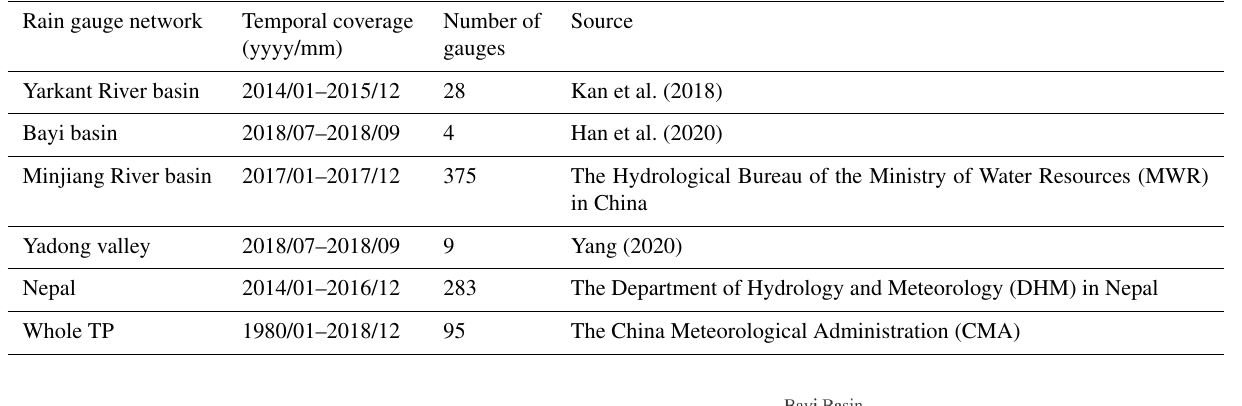
Table 1. Basic information about the six rain gauge networks used in this study.